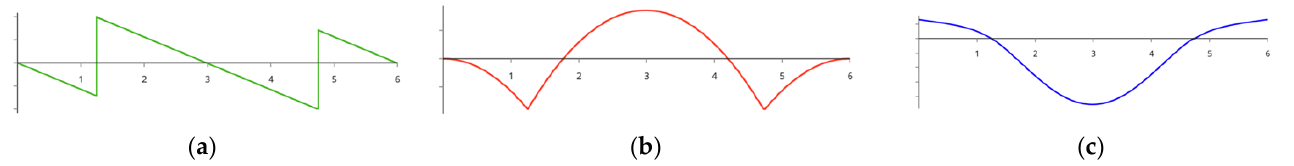
Figure A2. Joist ( a ) shear force diagram, ( b ) bending moment diagram, and ( c ) deflection diagram over the joist length in m. Table A1. Single-span joist load table for London, Ontario. Maximum Component